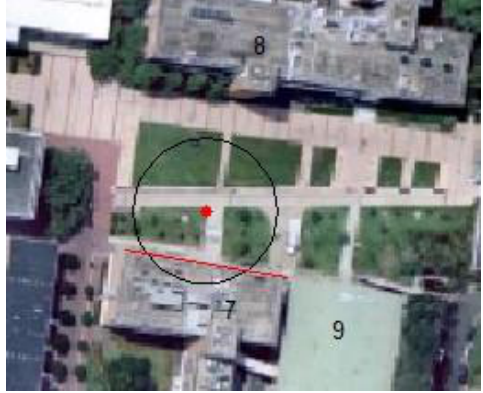
Figure 6. Given a GPS position data from mobile device at P shown with red dot, a circle is drawn with 20 m radius representing the search space. Line segment from building No. 7 crossed with the circle, so reference images of building No. 7 are chosen for image space.